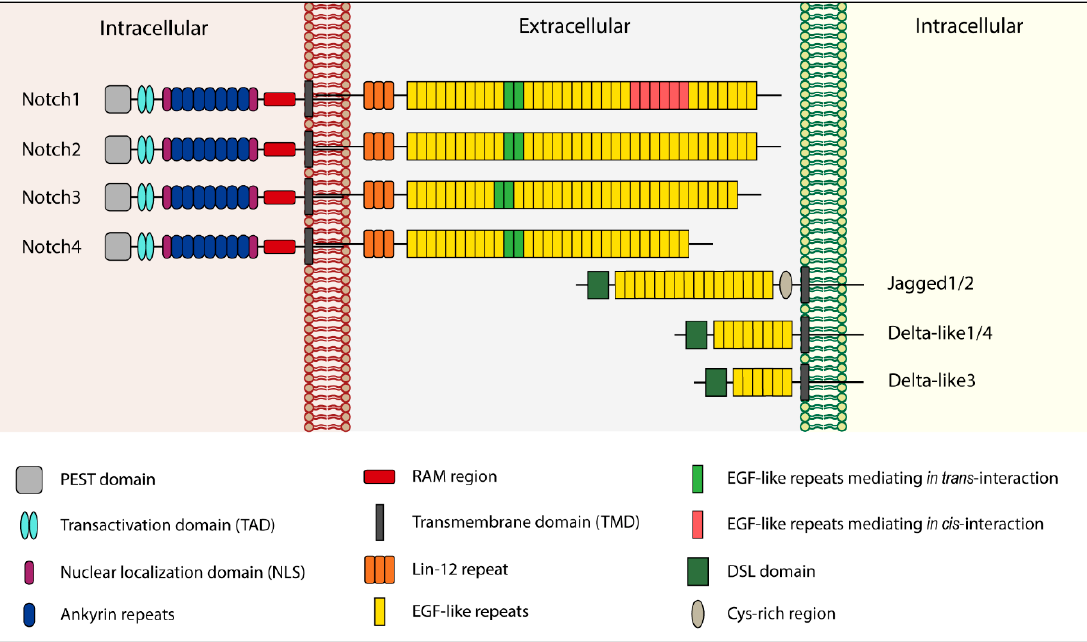
Figure 1. Structure of human Notch receptors and ligands.